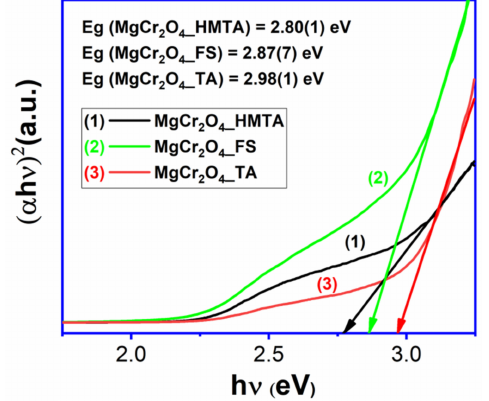
Figure 4. Direct Tauc plot transition for MgCr 2 O 4 nanoparticles synthesized by hexamethylenete- tramine (HMTA) (1), fructose (FS) (2), and tartaric acid (TA)